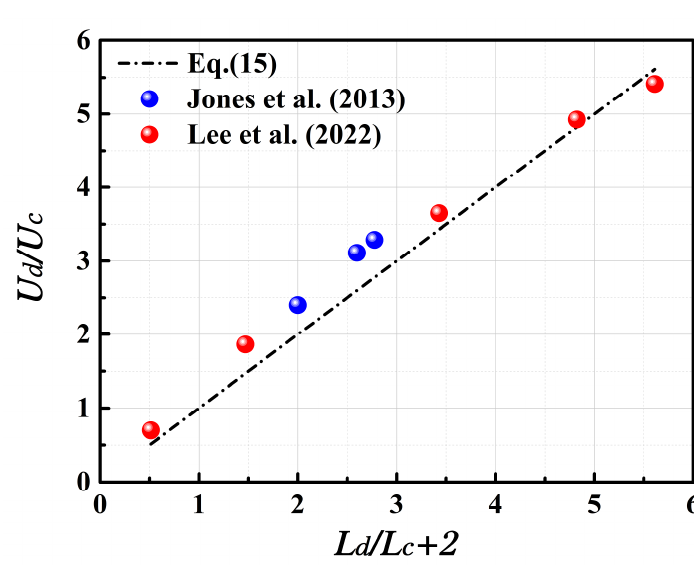
Figure 9. Comparison of the results of Equation (15) with the experimental results of Jones et al. [34] and the numerical results of Li et al [4].